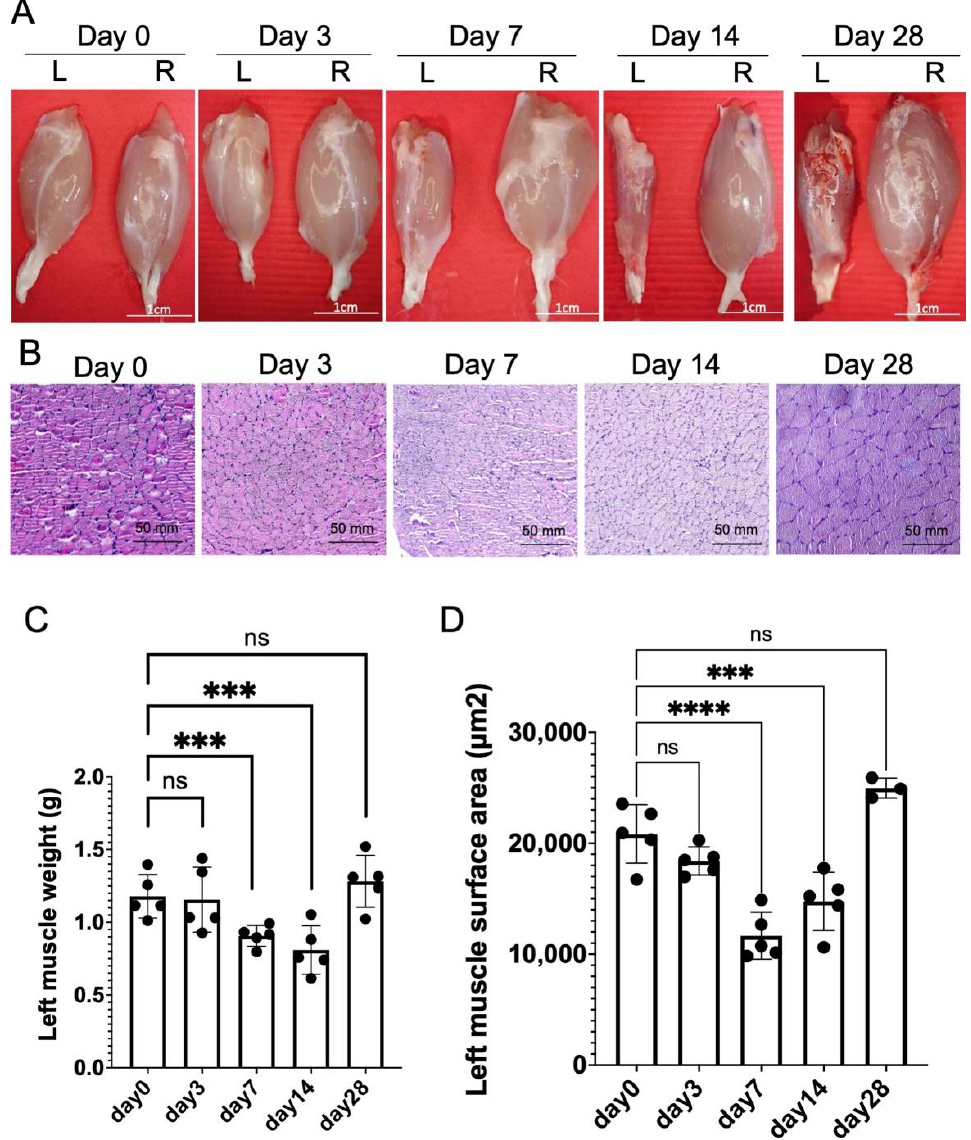
Figure 2. Gastrocnemius muscle evaluation by 1 week CCI. ( A , C ) Multiple time point analysis of gastrocnemius muscle at post nerve release day 0, 3, 7, 14 and 28 (L: left injured side; R: right uninjured side). Left gastrocnemius muscle weight demonstrated significant decrease till post release day 14, with recovery at day 28 after nerve release. (Scale bar: 1 cm. Data was presented with mean ± standard deviation, *** indicated p < 0.001, **** indicated p < 0.0001, ns indicated no significant difference) ( B , D ) Histology of affected side muscle fiber demonstrated decrease of left muscle fiber surface area from day 0 to day 14, with increase at day 28 after nerve release. (Scale bar: 50 mm. Data was presented with mean ± standard deviation).